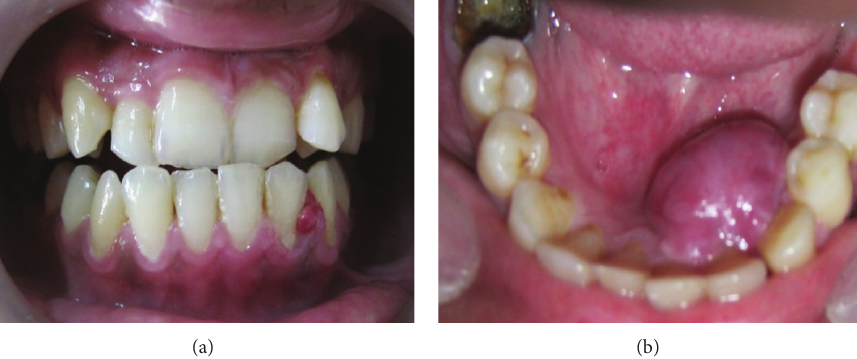
Figure 1: Clinical picture. (a) shows small growth buccally between 32 and 33. (b) shows growth in lingual alveolar mucosa.